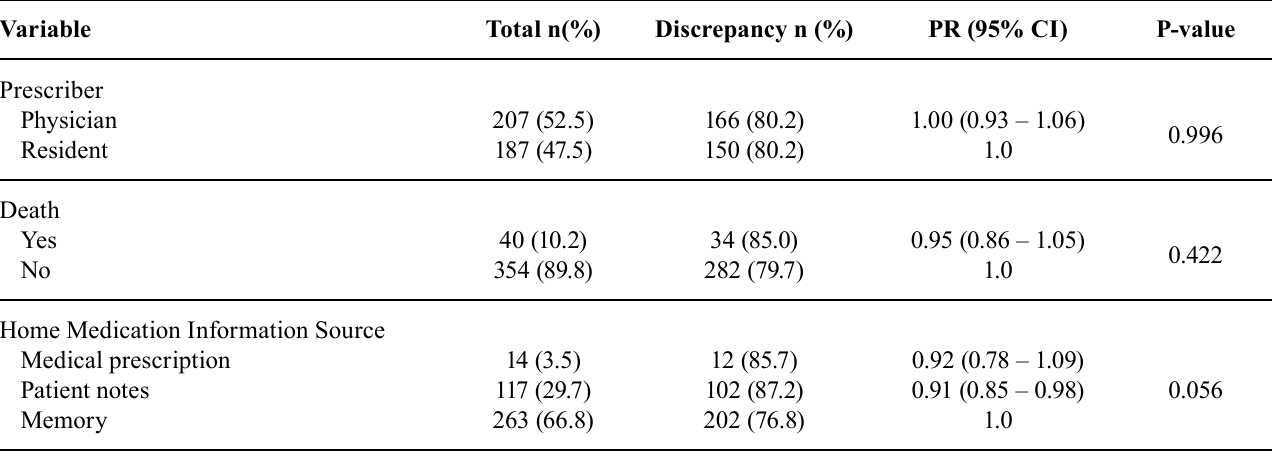
TABLE I – A nalysis of the association between sociodemographic and clinical variables and medication discrepancies in the surveyed hospital, 2015-2016 (n = 394)